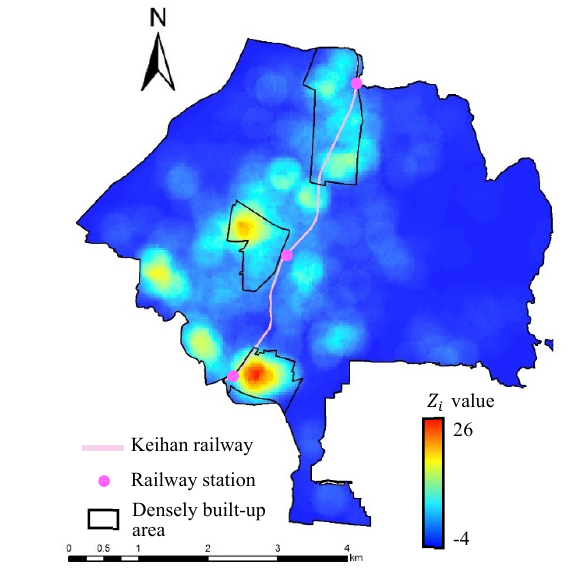
Figure 3. Result of the application of spatial autocorrelation analysis to the water hydrants classified as “Vacant house”. Gradations in colour from blue to red denote Z i